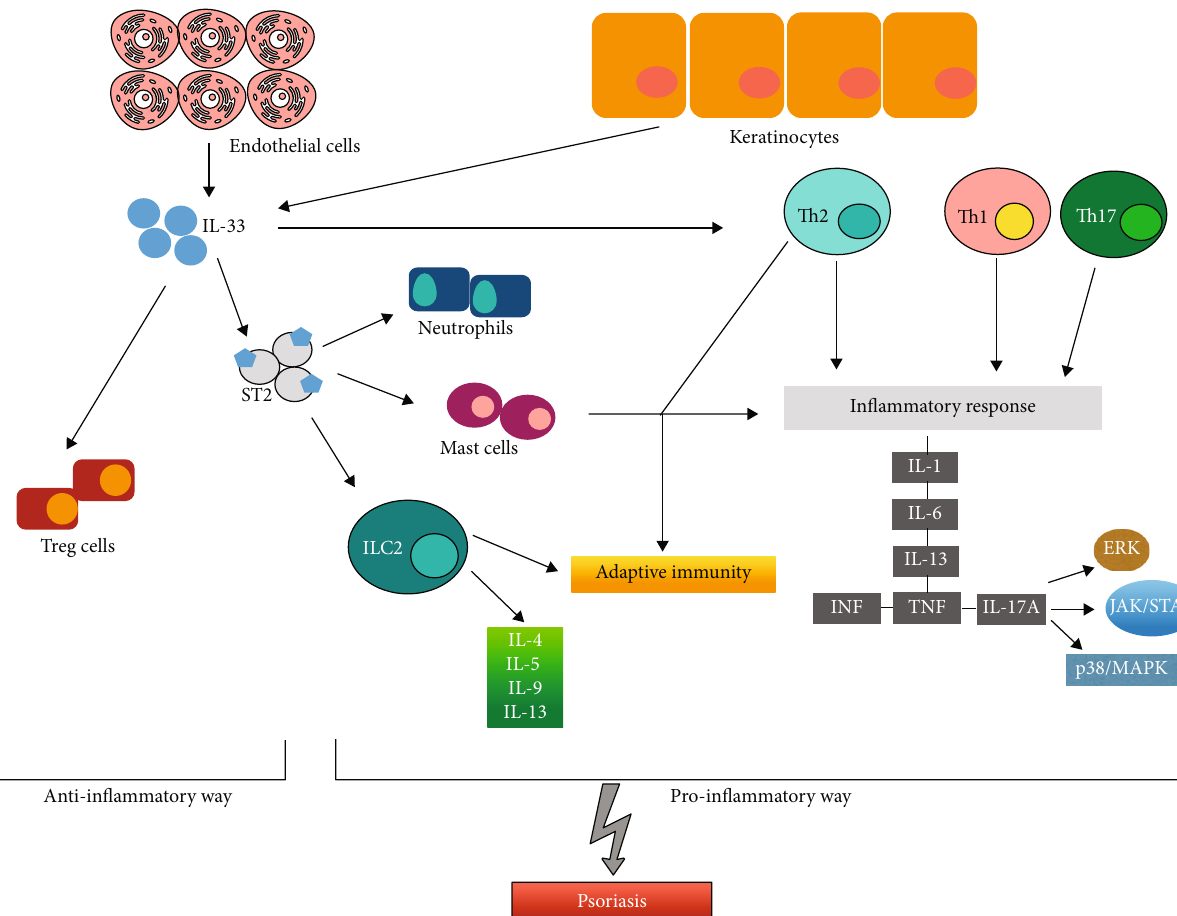
Figure 1: In fl ammatory and immunological pathways activated by IL-33 causing the onset of